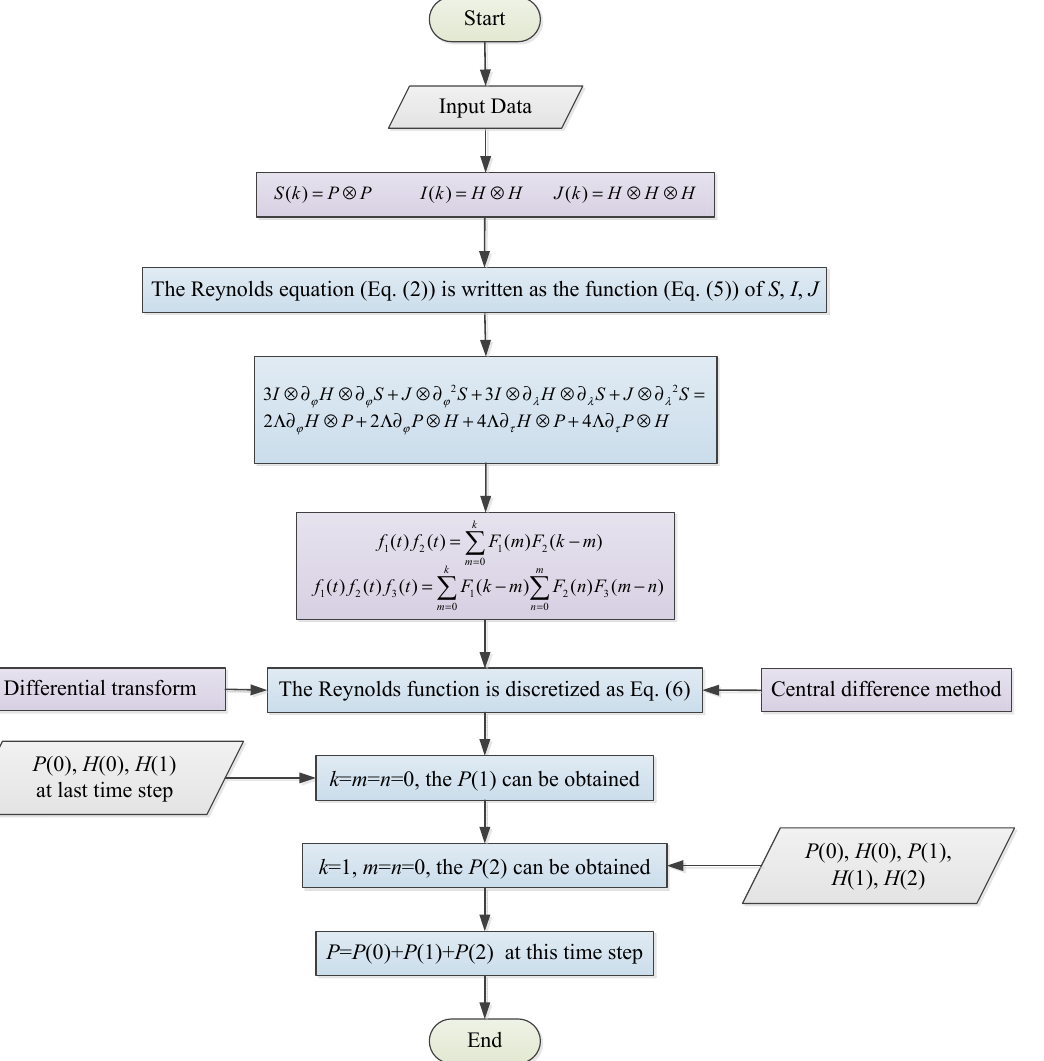
Figure 2. The calculation flow chart of the differential transform method.